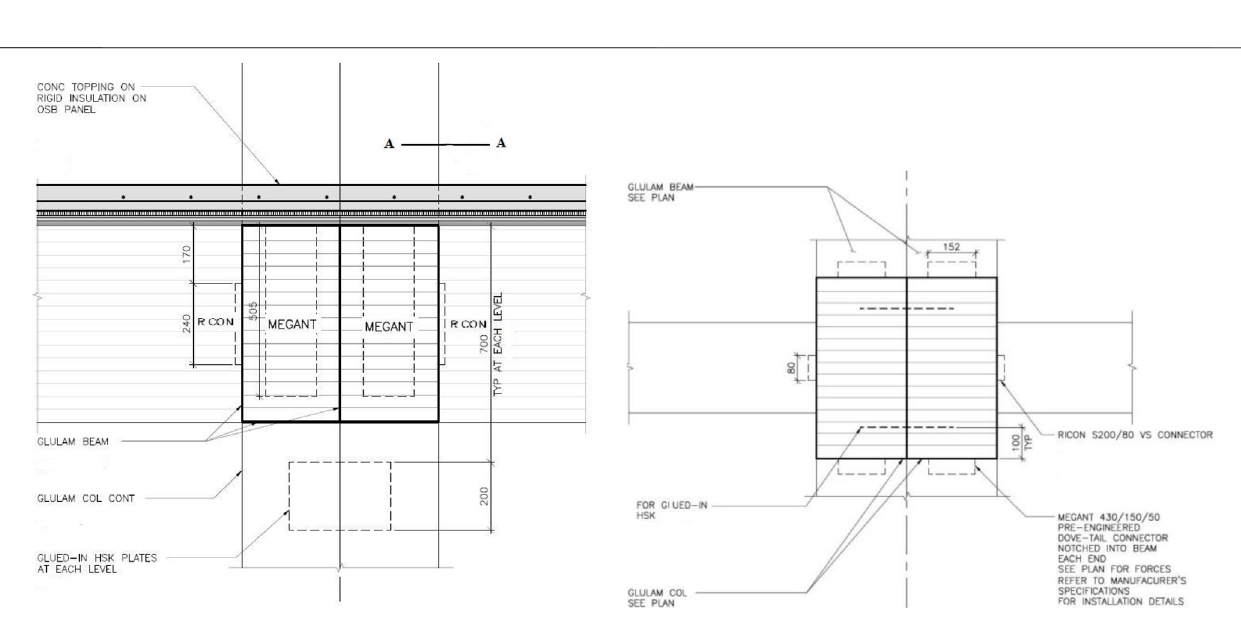
FIGURE 14 | Ricon and megant connections typical beam to column